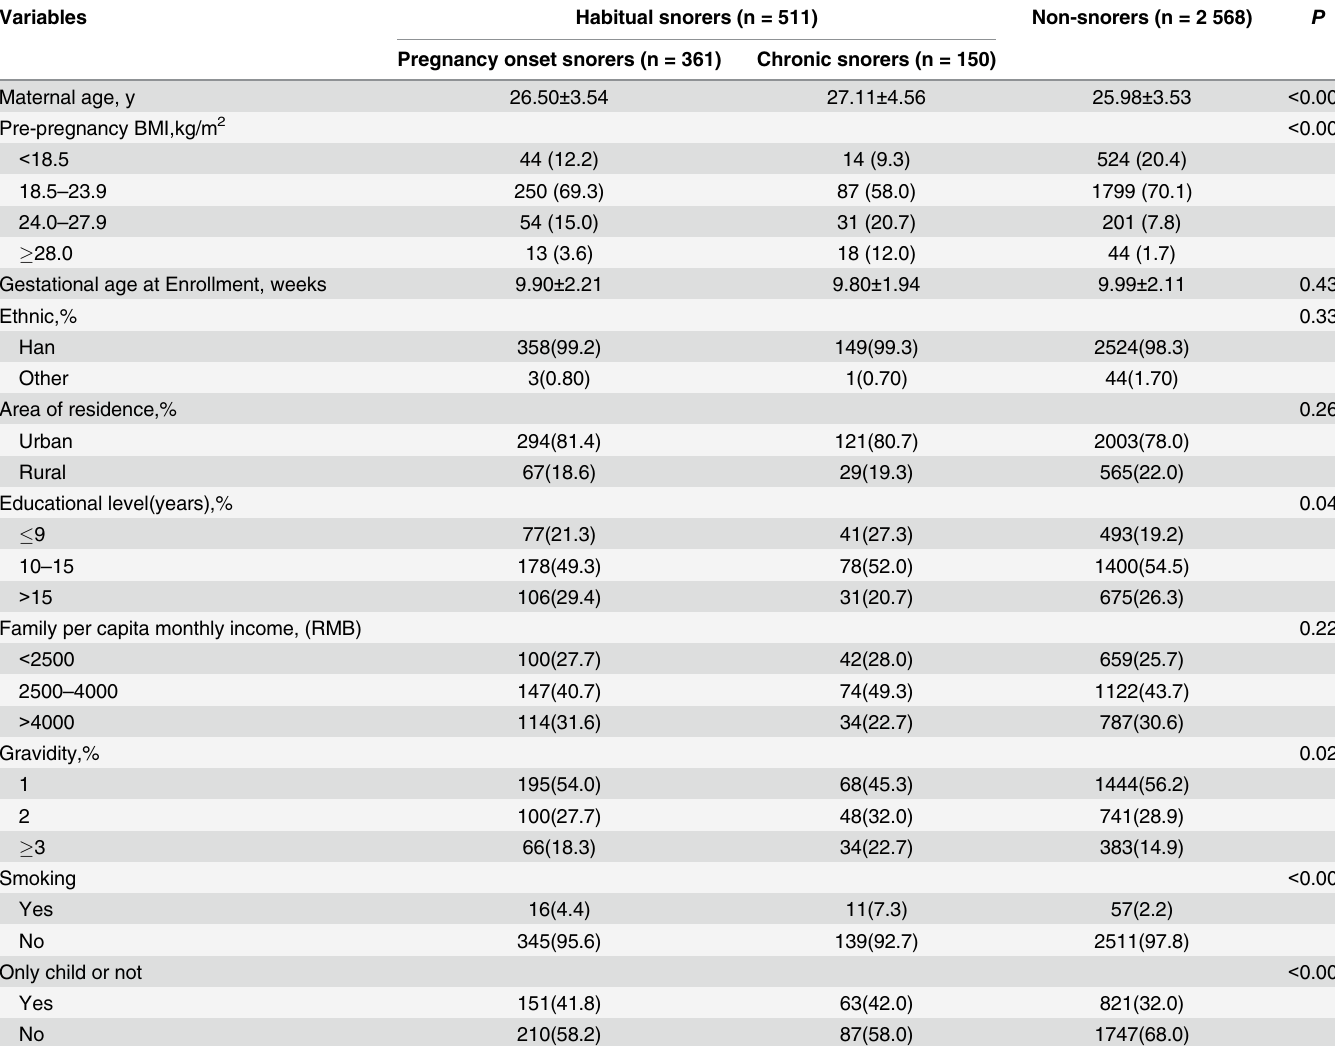
Table 1. Comparison of baseline characteristics in habitual snorers and